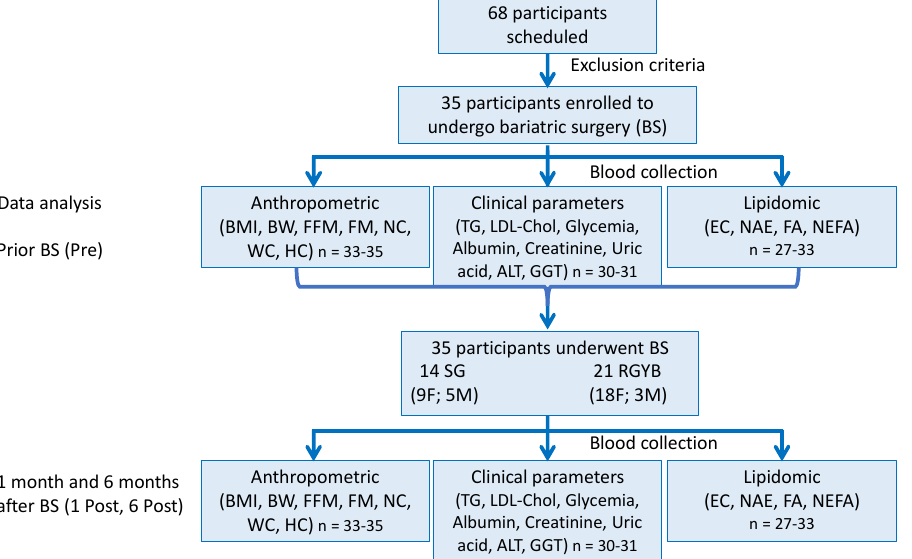
Scheme 1. Study design and experimental procedure. Discrepancy in number of subjects, n , in data analysis are due to the limited sample amount available and/or their loss during the analysis procedure. Body mass index (BMI), free fat mass (FFM), fat mass (FM), neck (NC), waist (WC), hip (HC) circumferences, triglycerides (TG), LDL-cholesterol